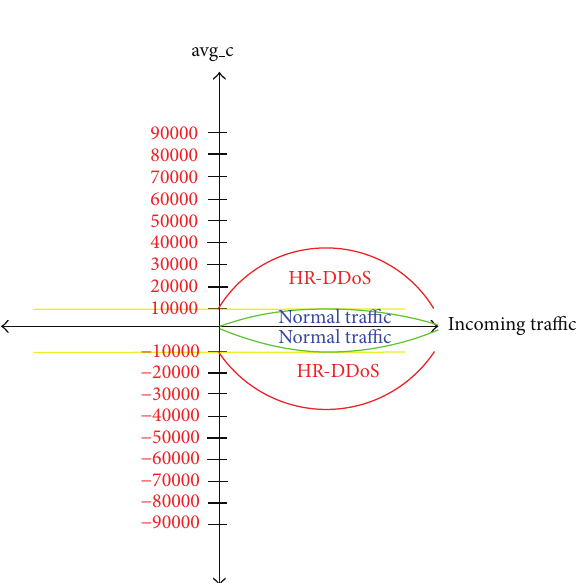
Figure 6: Clicks’ average of the cold web